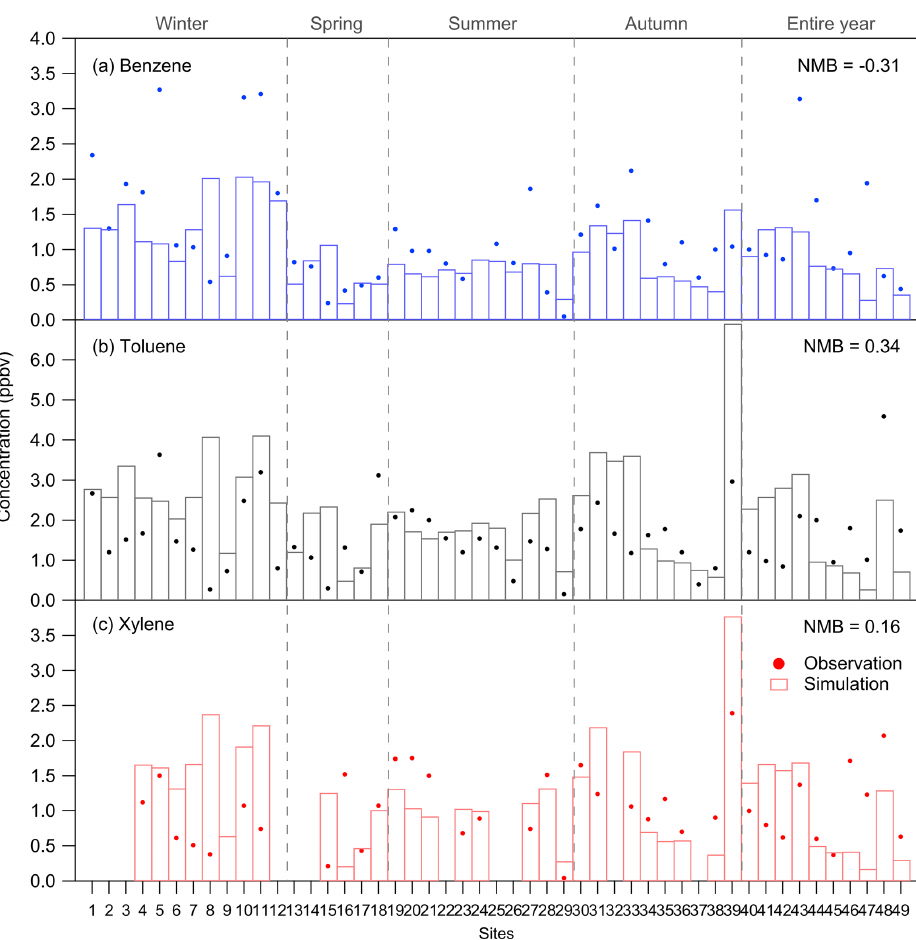
Figure 4. Comparisons of the observed campaign-average mixing ratios of benzene, toluene, and xylene in China with those simulated by the Cp_base simulation. Note that the mixing ratios of these aromatic compounds in the Cp_base, Cp_R1, Cp_R1 + 2, and Cp_R1 + 2 + 3 simulations are